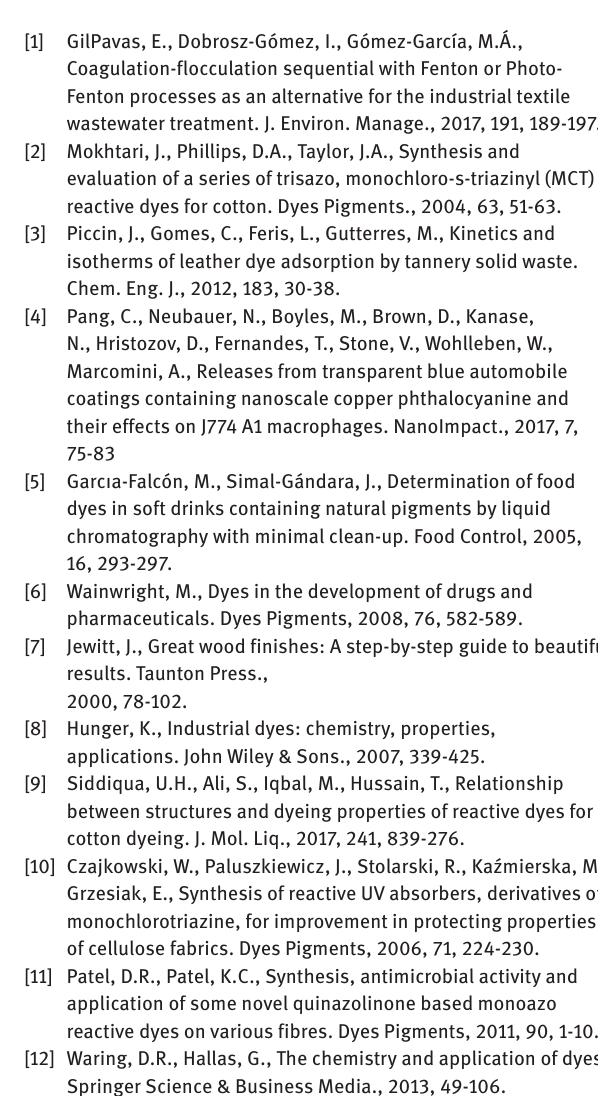
O oxidation for 2 2